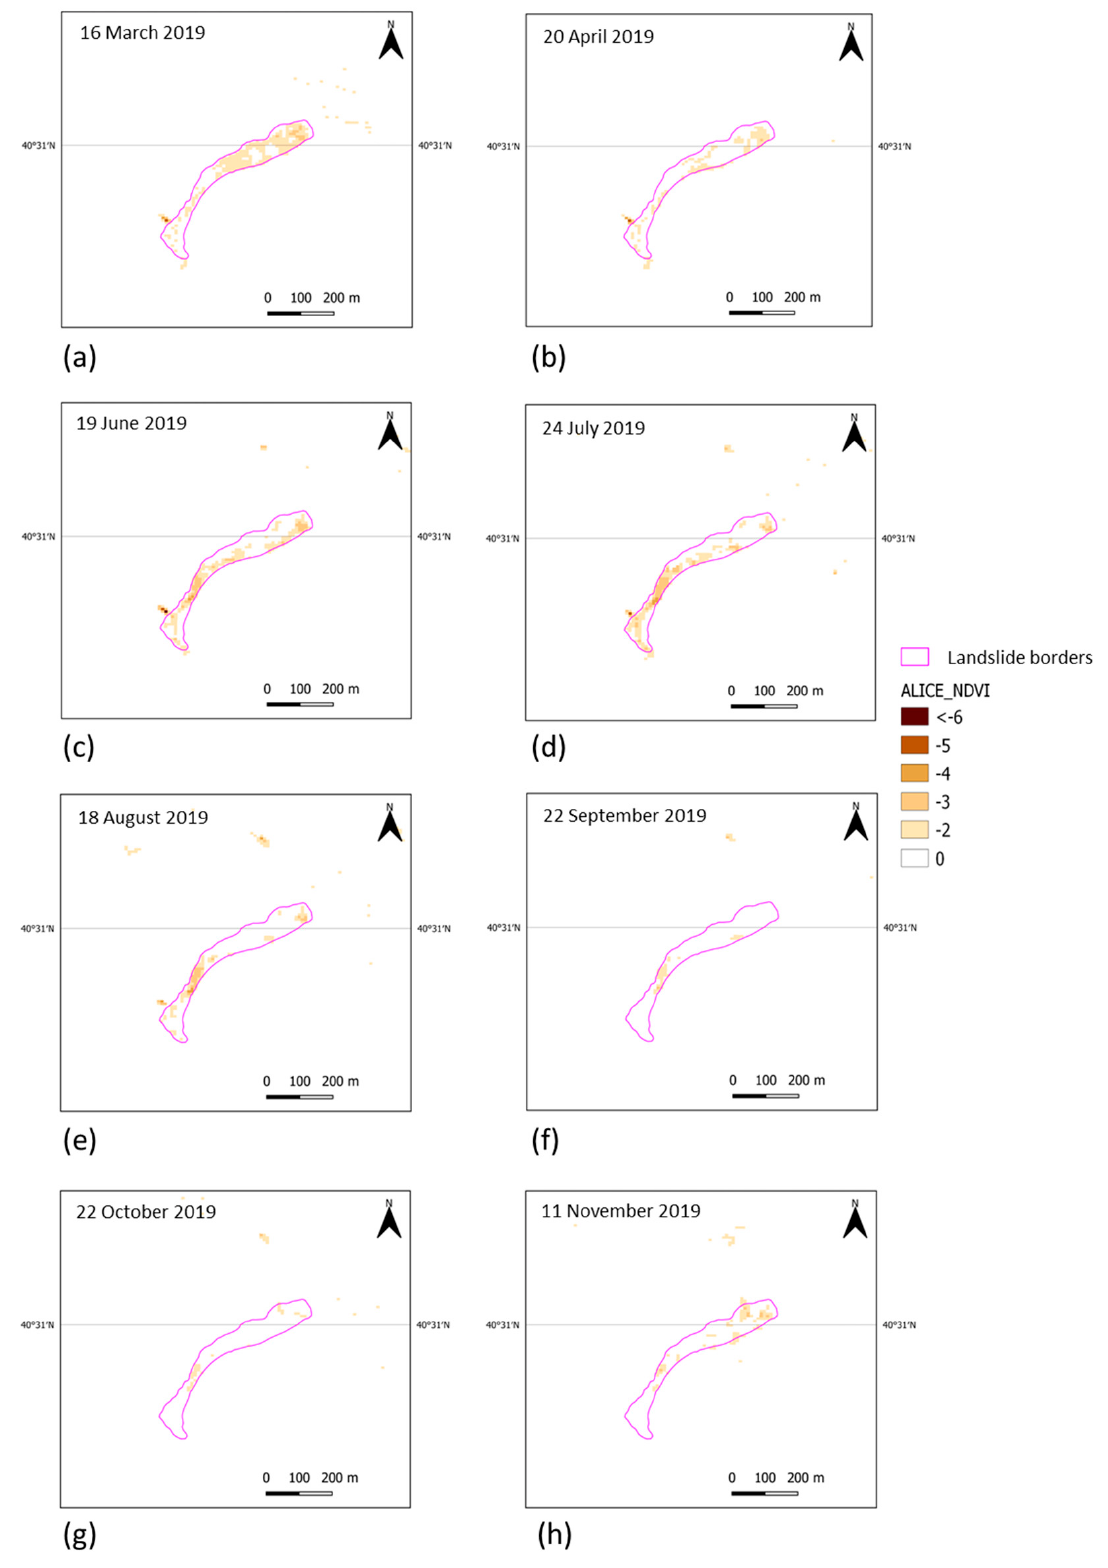
Figure 8. ⊗ NDVI ( x,y,t ) computed for the following Sentinel − 2 L1C images: ( a ) 16 March 2019; ( b )